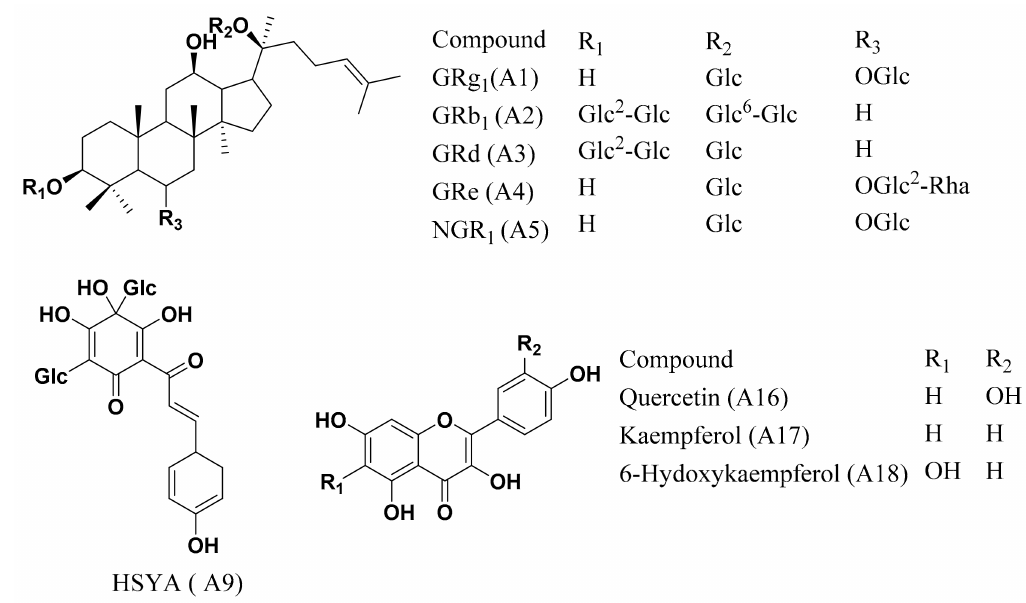
Figure 1. The chemical structures of the main components contained in the combination of Carthamus tinctorius extract and notoginseng total saponins